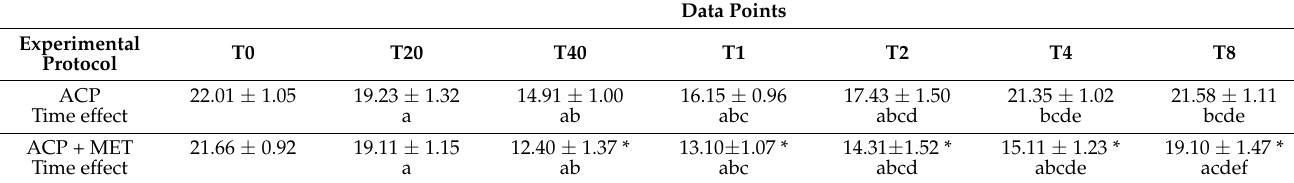
Table 2. Mean values ± standard deviation of STT 1 readings, expressed in mm/min, in the different experimental protocols (acepromazine: ACP; acepromazine + methadone: ACP + MET) in all data points. Their statistical differences were also reported: a vs. T0 p < 0.001; b vs. T20 p < 0.001; c vs. T40 p < 0.001; d vs. T1 p < 0.001; e vs. T2 p < 0.05; f vs. T4 p < 0.001; * vs. ACP p <